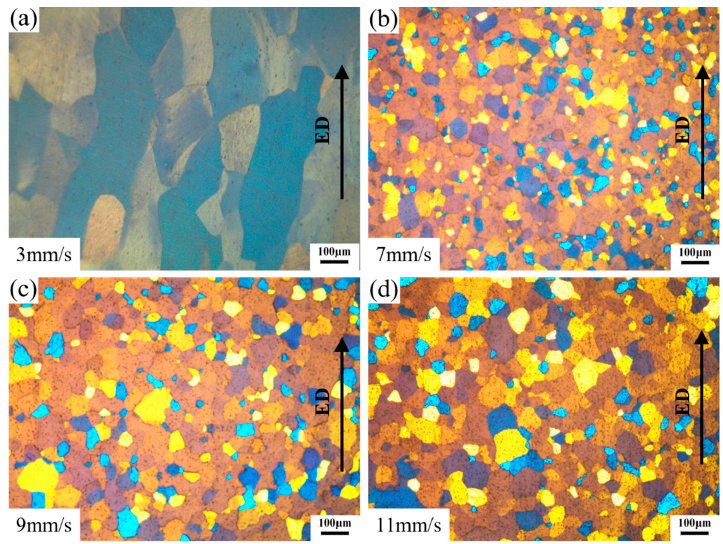
Figure 8. Microstructures of the extruded material on longitudinal cross-section. ( a – d ) different ram speed.